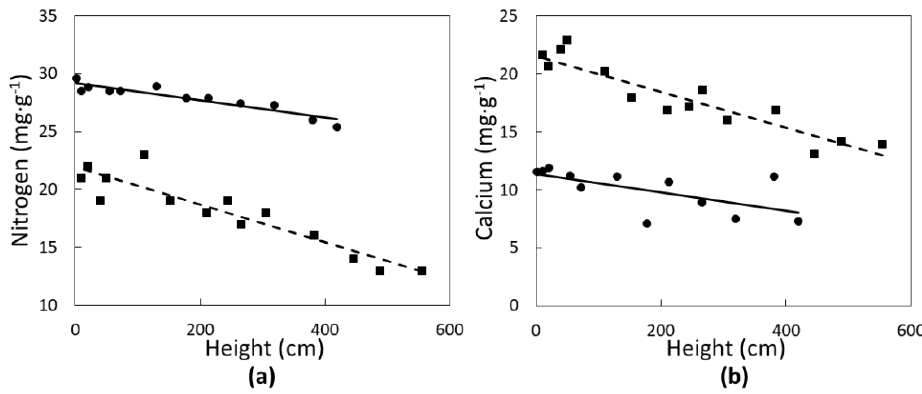
Figure 2. The influence of Cycas micronesica tree height on ( a ) nitrogen and ( b ) calcium green leaf concentration in Rota (squares and dashed line) and Yap (circles and solid line).